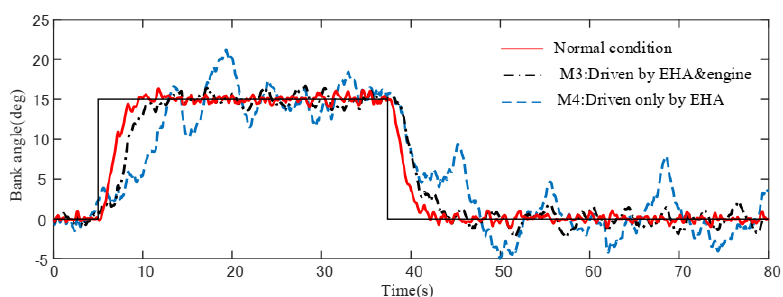
Figure 17. Bank angle response for damage scenario II under uncertainties and turbulences.